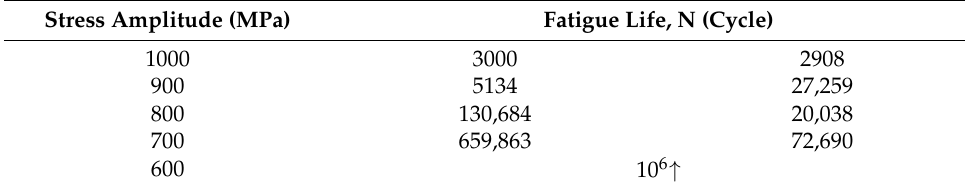
Table 6. The fatigue test result of SKD61 at 400 ◦ C. Stress Amplitude (MPa)